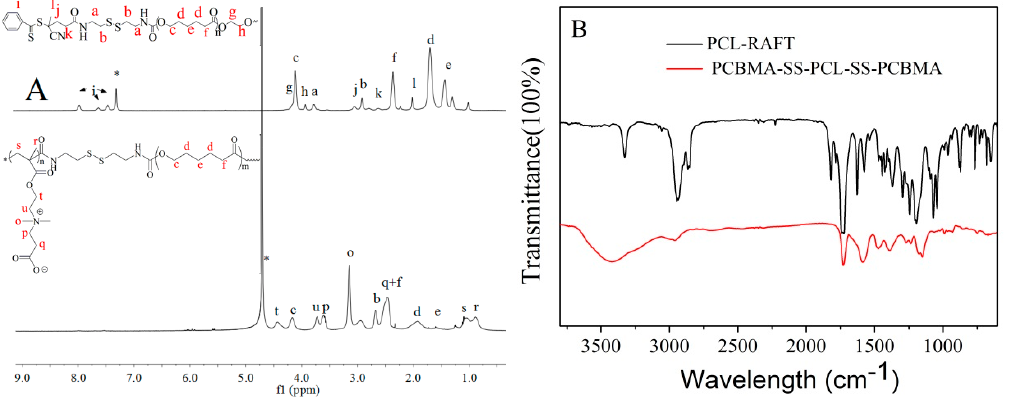
Figure 1. 1 H NMR spectra ( A ) and FT-IR spectra ( B ) of PCL macro-RAFT and PCBMA-SS-PCL-SS-PCBMA.